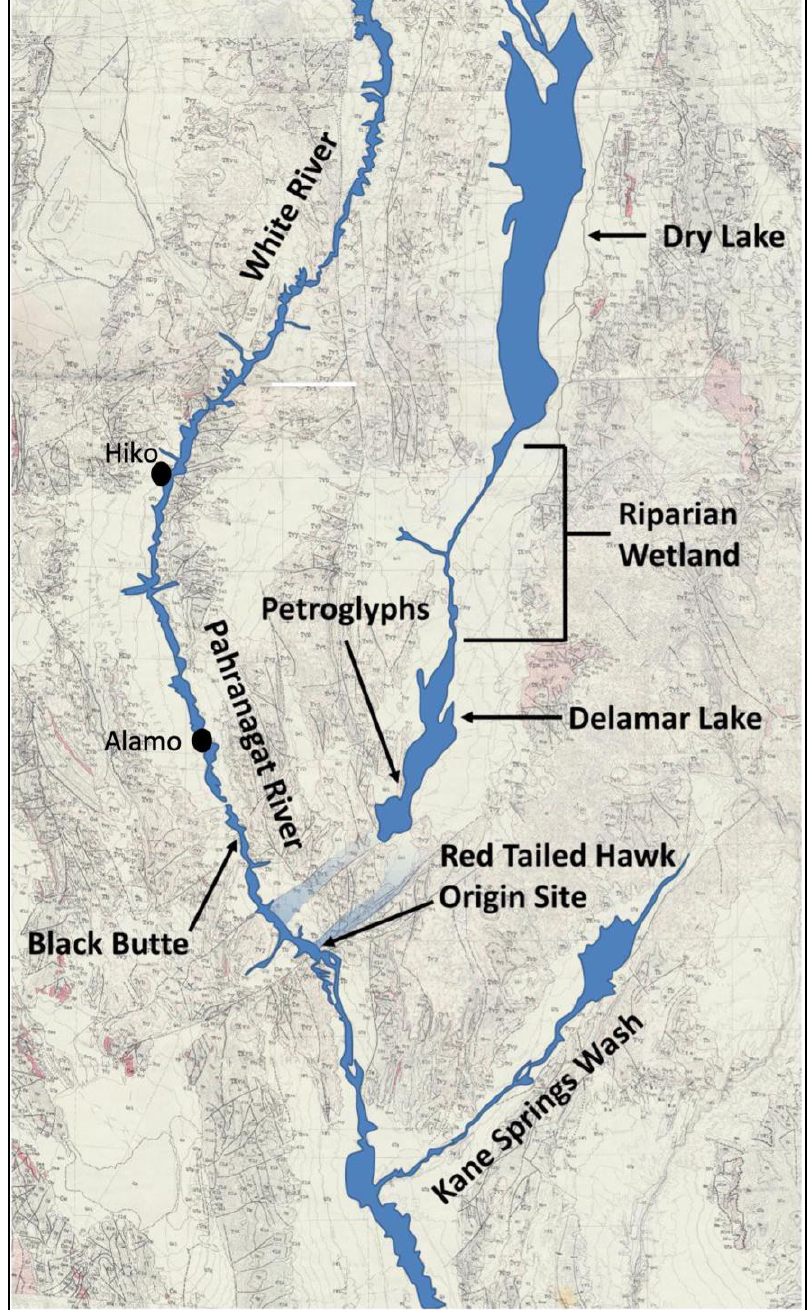
Figure 6. Hydrological systems in Pahranagat Valley [52].